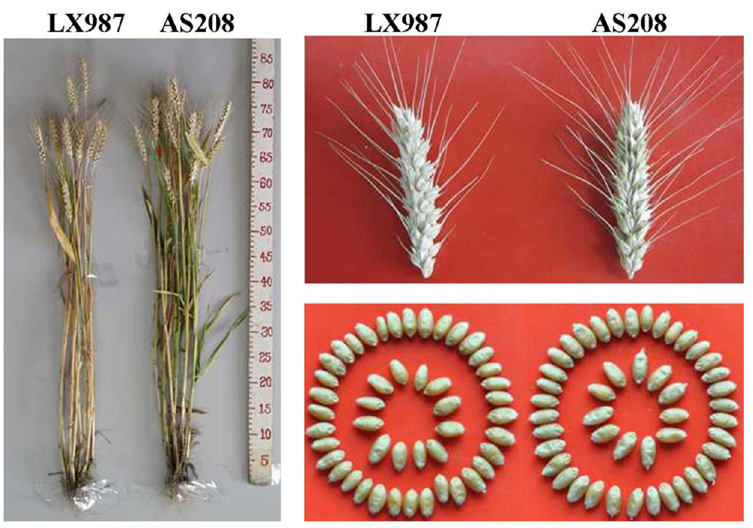
Fig 1. Comparison of main agronomic and seed traits between AS208 and LX987. AS208 was identical to its parental cultivar of LX987 in plant height, spike length, and grain shape.